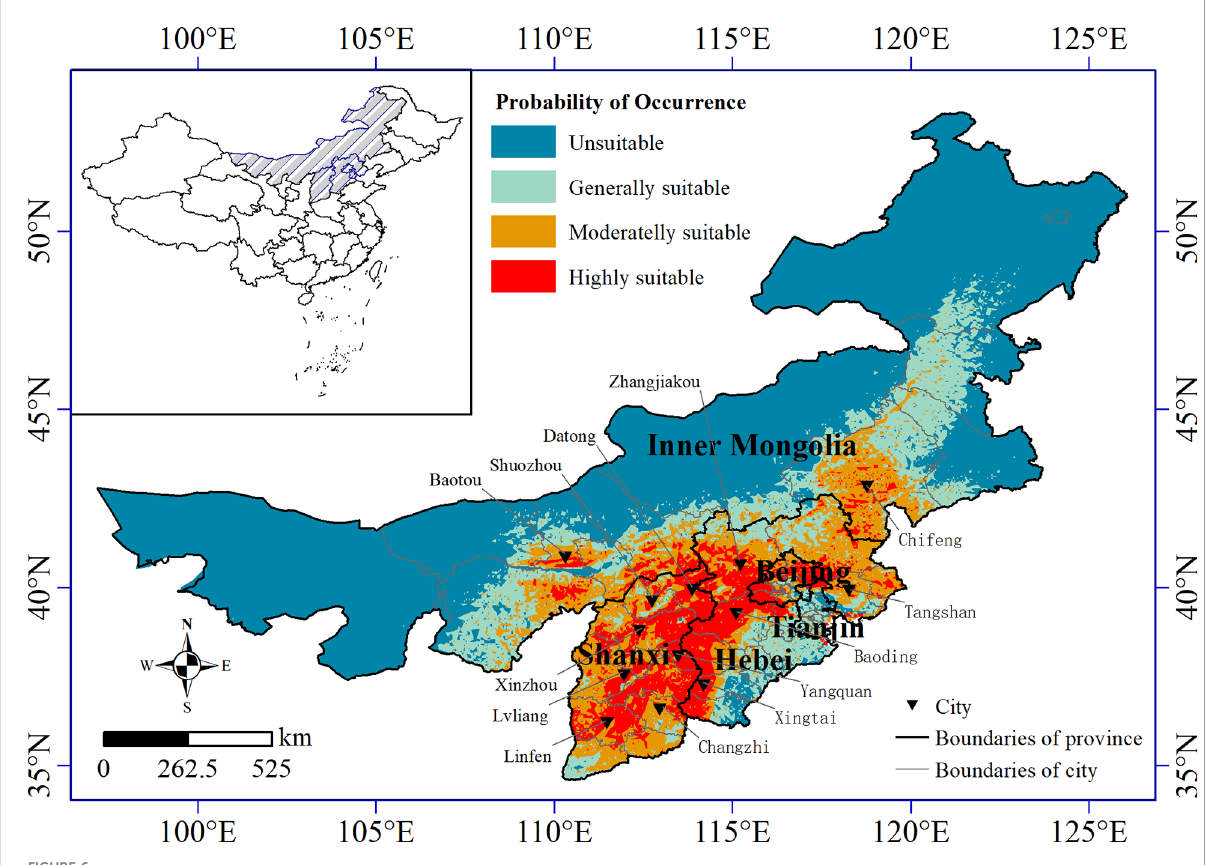
FIGURE 6 Suitable growing area for naked oat under modern climatic